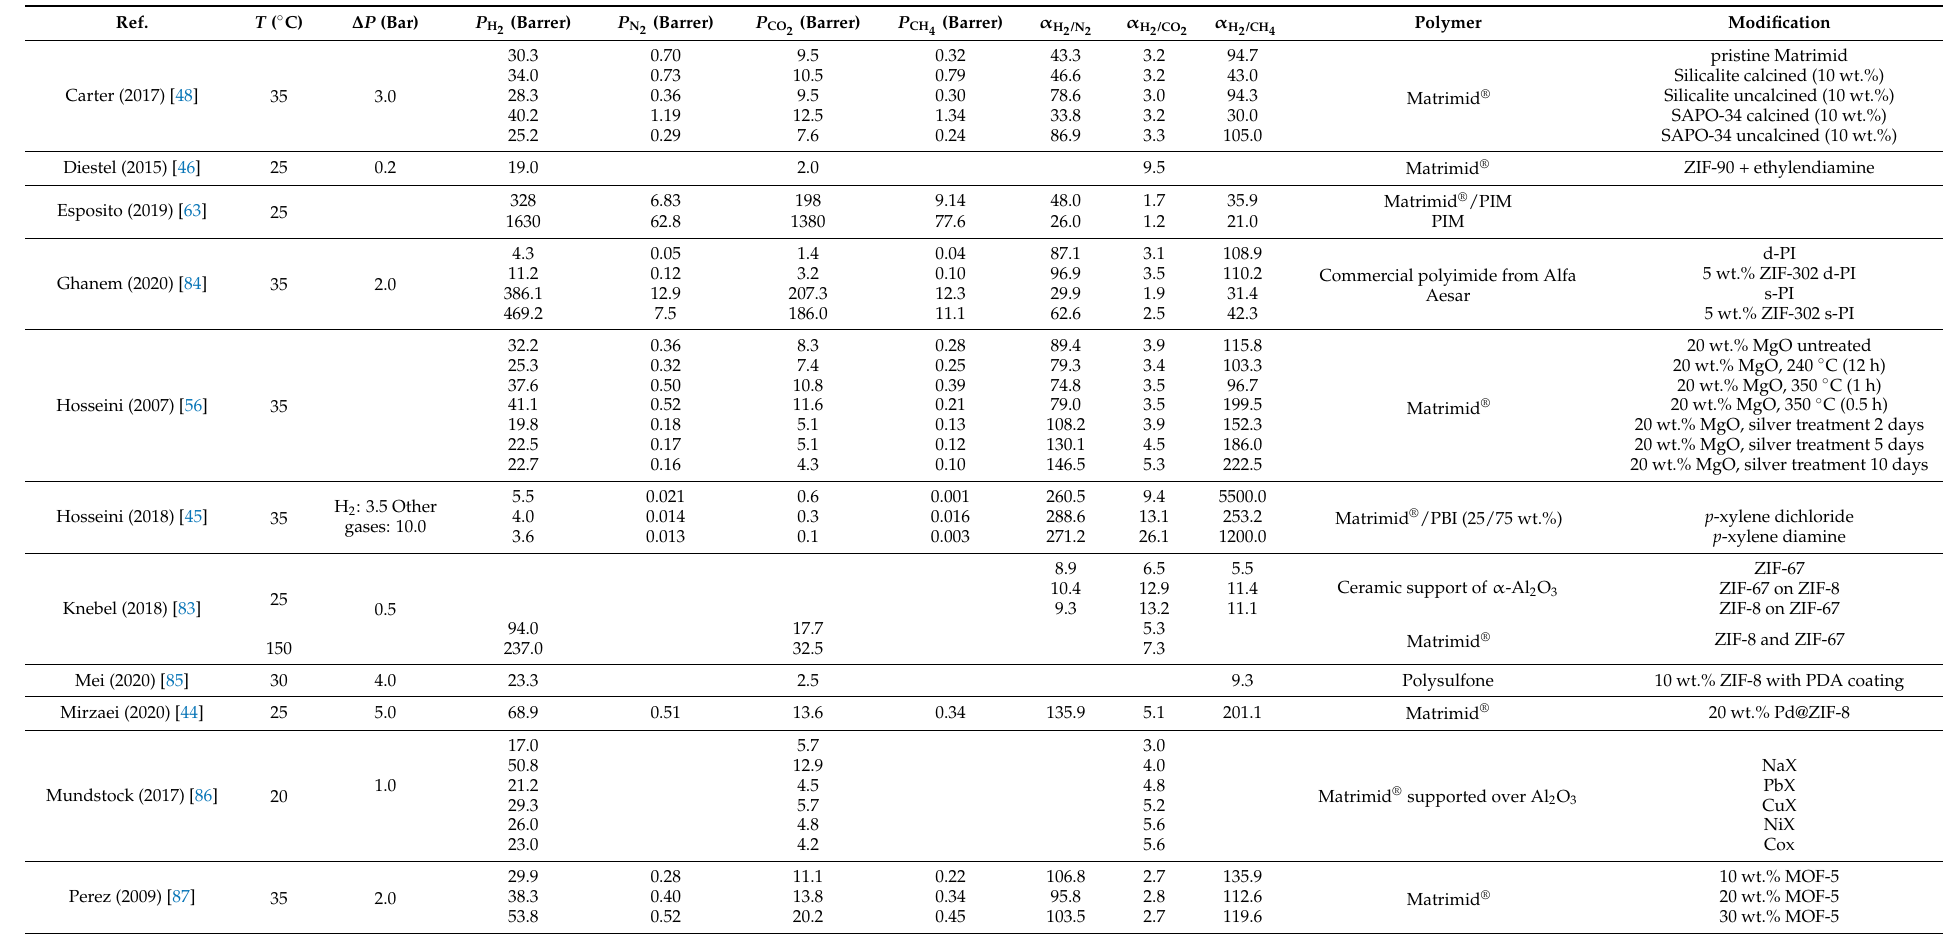
Table 5. Main bibliographical data in terms of pure gas H 2 , N 2 , CO 2 and CH 4 permeabilities and selectivities through modified Matrimid ® /ZIF MMMs in which polymer has been substituted or blended, the MMM has been chemically modified and/or the filler has been substituted or functionalized.